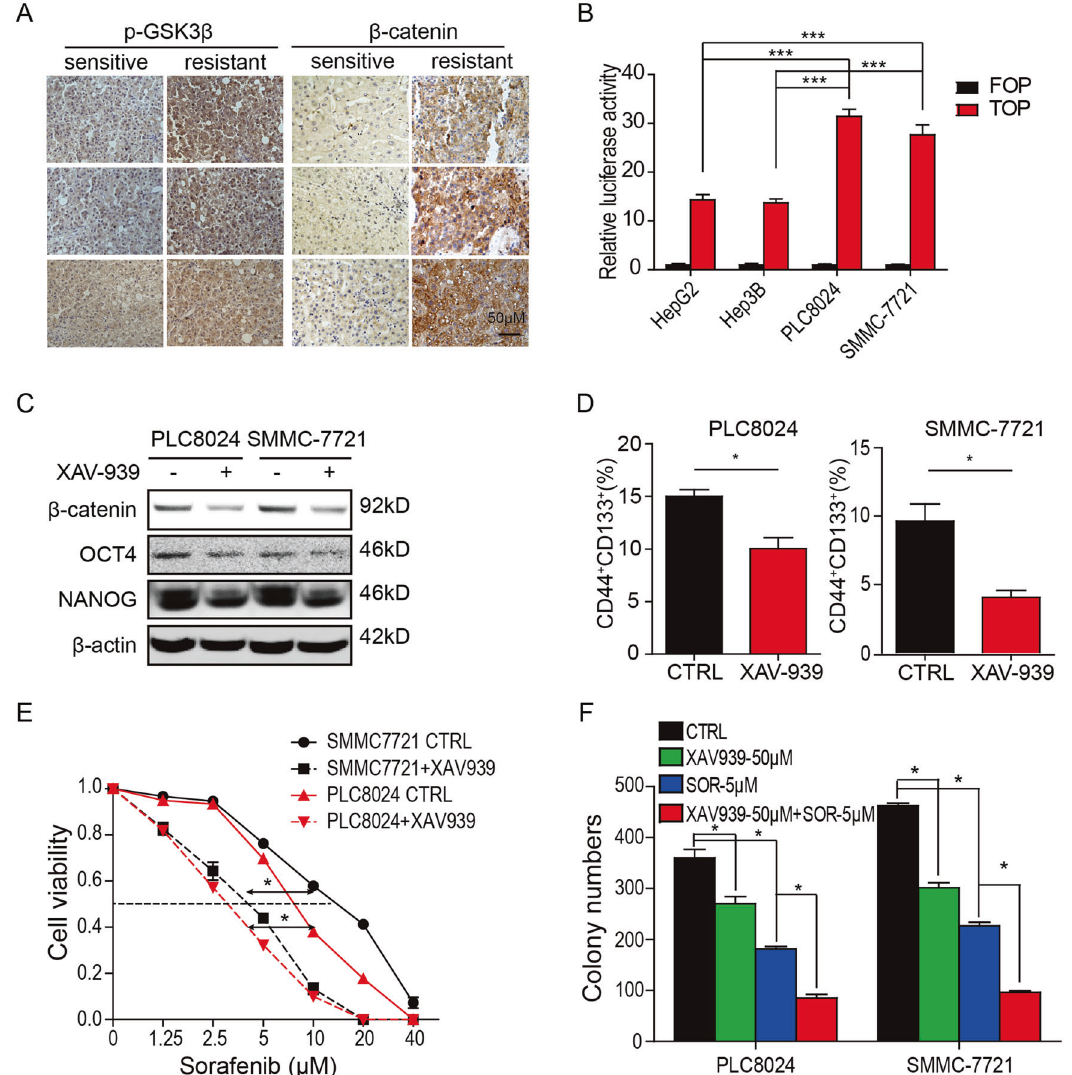
Fig. 2 Wnt signaling is activated in sorafenib-resistant hepatocellular carcinoma cells. A Wnt signaling pathway was activated in sorafenib- resistant HCC tumors. Bar = 100 μ m. B β -catenin activity was increased in sorafenib-resistant HCC cells. The TOP/FOP-Flash reporter assay was performed. C The Wnt inhibitor XAV-939 alleviated the expression of OCT4 and NANOG in sorafenib-resistant HCC tumors. Cells were treated by XAV-939 at the indicated dose for 2 days. D XAV-939 decreased the proportion of CD44 + CD133 + subpopulation in sorafenib-resistant HCC tumors. The cells were treated by 50 μ M XAV-939 for 2 days. * P < 0.05. E XAV-939 inhibits cell growth of sorafenib-resistant HCC cells. The cell viability of HCC cells was analyzed by CCK8. Data were presented as mean ± SD ( n = 3). * P < 0.05. F XAV-939 reduced colony formation in sorafenib-resistant SMMC-7721 and PLC8024 cells. The cells were treated with 50 μ M of XAV-939 alone or 5 μ M of sorafenib alone or the combination. * P < 0.05.